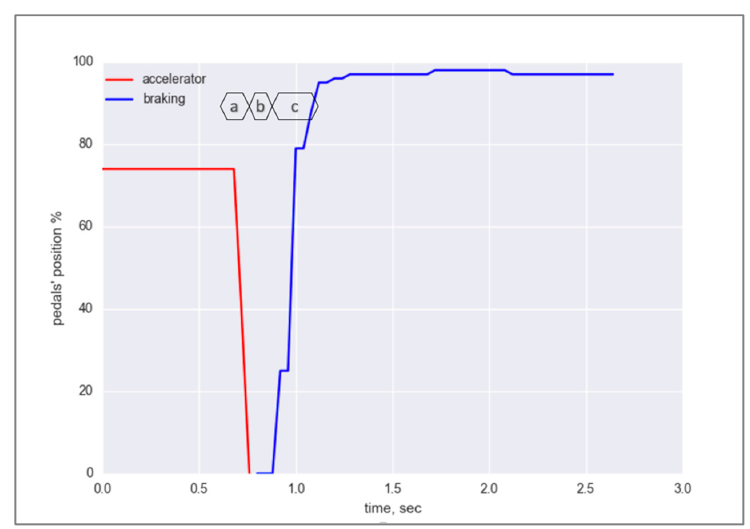
Figure 3. Typical dynamics of accelerator- and brake pedals during emergency braking.